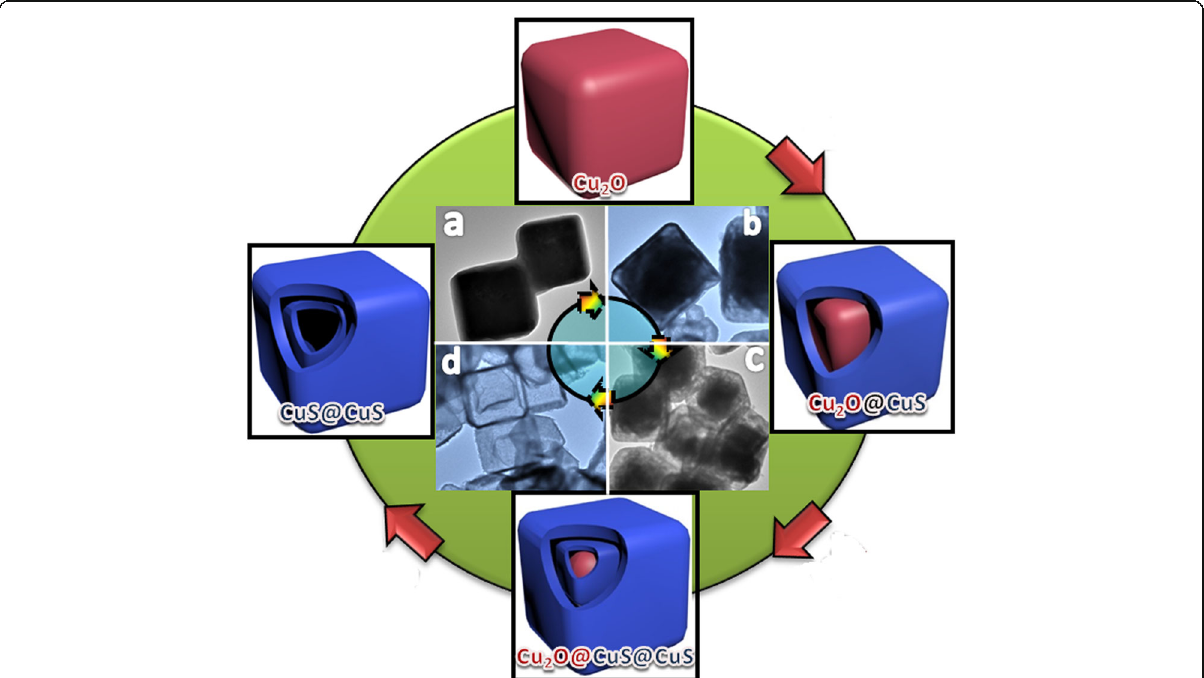
Fig. 1 The synthetic process of 2-CuS NCs. The inset represents TEM images matched with a Cu 2 O, b Cu 2 O@CuS, c Cu 2 O@CuS@CuS, and d